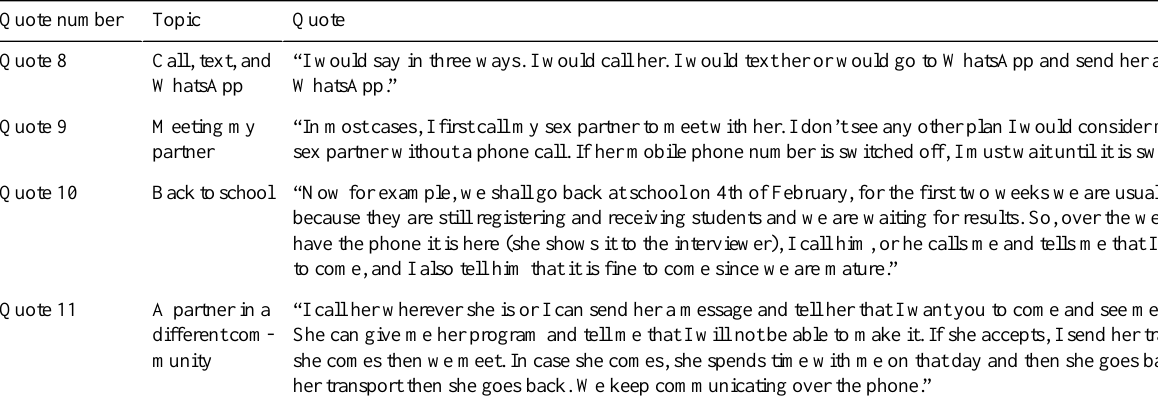
Table 4. Mobile phones for communicating with sexual partners. QuoteTopicQuote